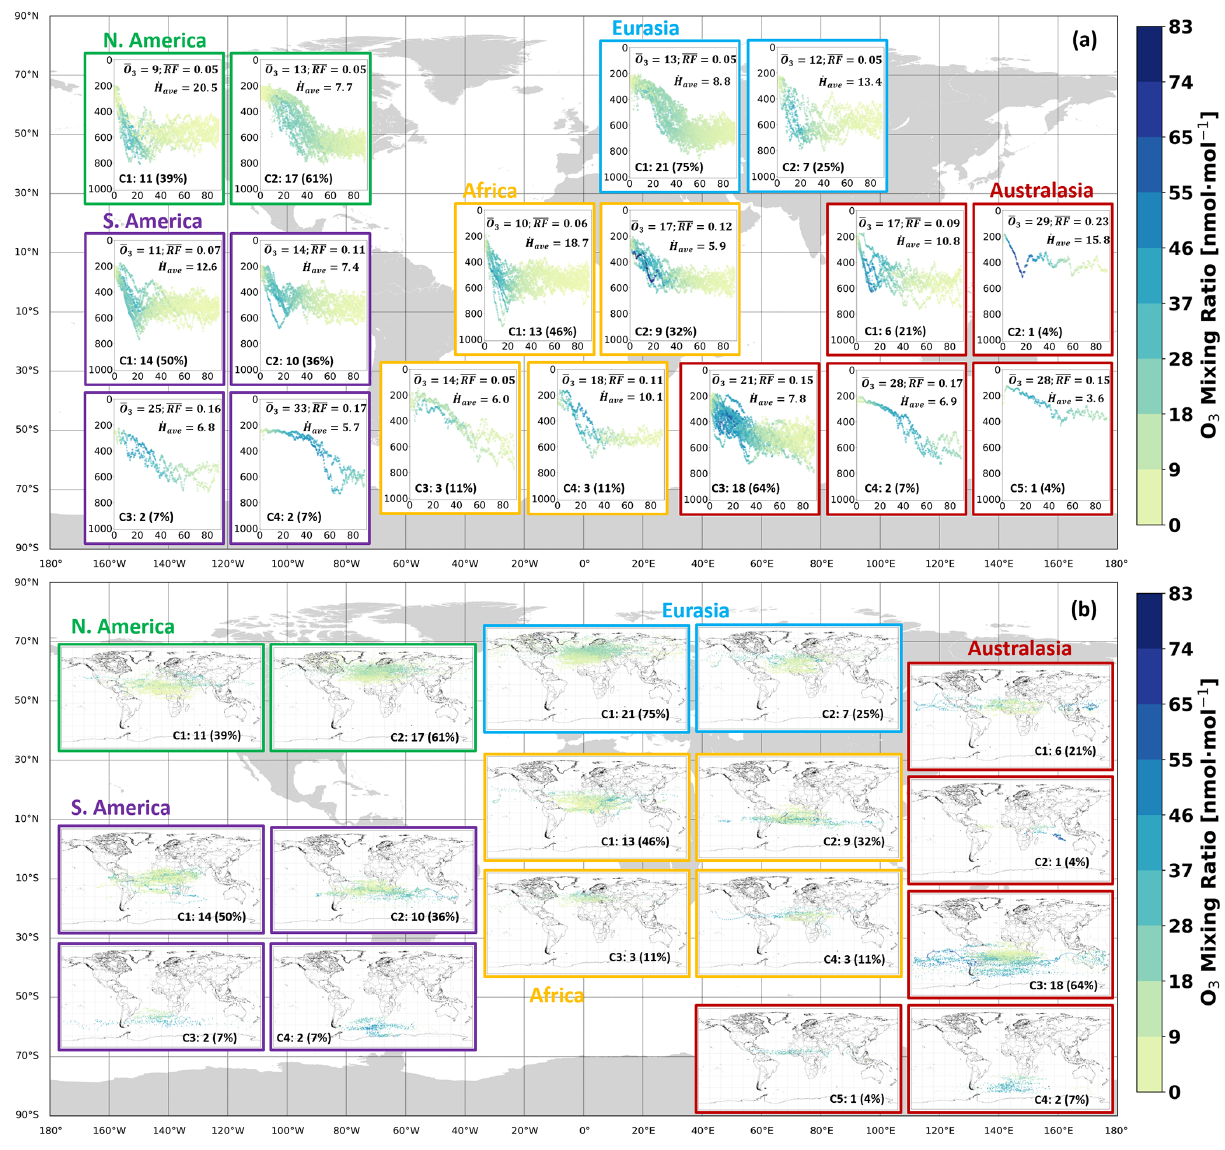
Figure 12. (a) Vertical profile of clusters of NO x transport pathways during January 2014. The color bar represents the mean O 3 disturbance in nanomoles per mole (nmolmol − 1 ) caused by the emission transported along a median trajectory. Each “C” represents a distinct and independent cluster; i.e., C1 from N. America is not related to C1 from S. America. Each cluster label is followed by the number of median trajectories that it comprises, both in absolute and relative terms. The 90d mean rate of descent in hectopascals per day (hPad − 1 ) for all median trajectories in a cluster is defined as ˙ H ave . The cluster radiative forcing contribution in milliwatts per square meter (mWm − 2 ) is labeled as RF, and O 3 is the mean disturbance of the median trajectories in nanomoles per mole (nmolmol − 1 ). Panel (b) uses the same notation but for the horizontal distributions. The axes for (a) are defined in Fig. 7a and b, while the axes for panel (b) are specified in Fig. 7c and d. Meteorological conditions considered are specific to the period 1 January–31 March